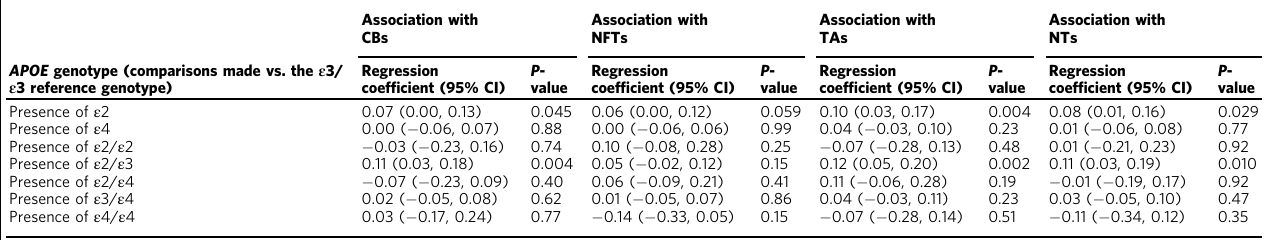
Regressioncoef fi cients,95%CIs,and P -valuesresultfrom linearregressionmodelsadjustedforageatdeath,gender,Braak NFTstage,andThalamyloidphase.Regressioncoef fi cientsareinterpreted as differenceinthemeanscoreofthegivenneuropathologicalfeature(wherescoreswerecalculatedbyaveragingthe0 – 3measuresacrossallanatomicalstructures)betweenthegiven APOE genotypeand